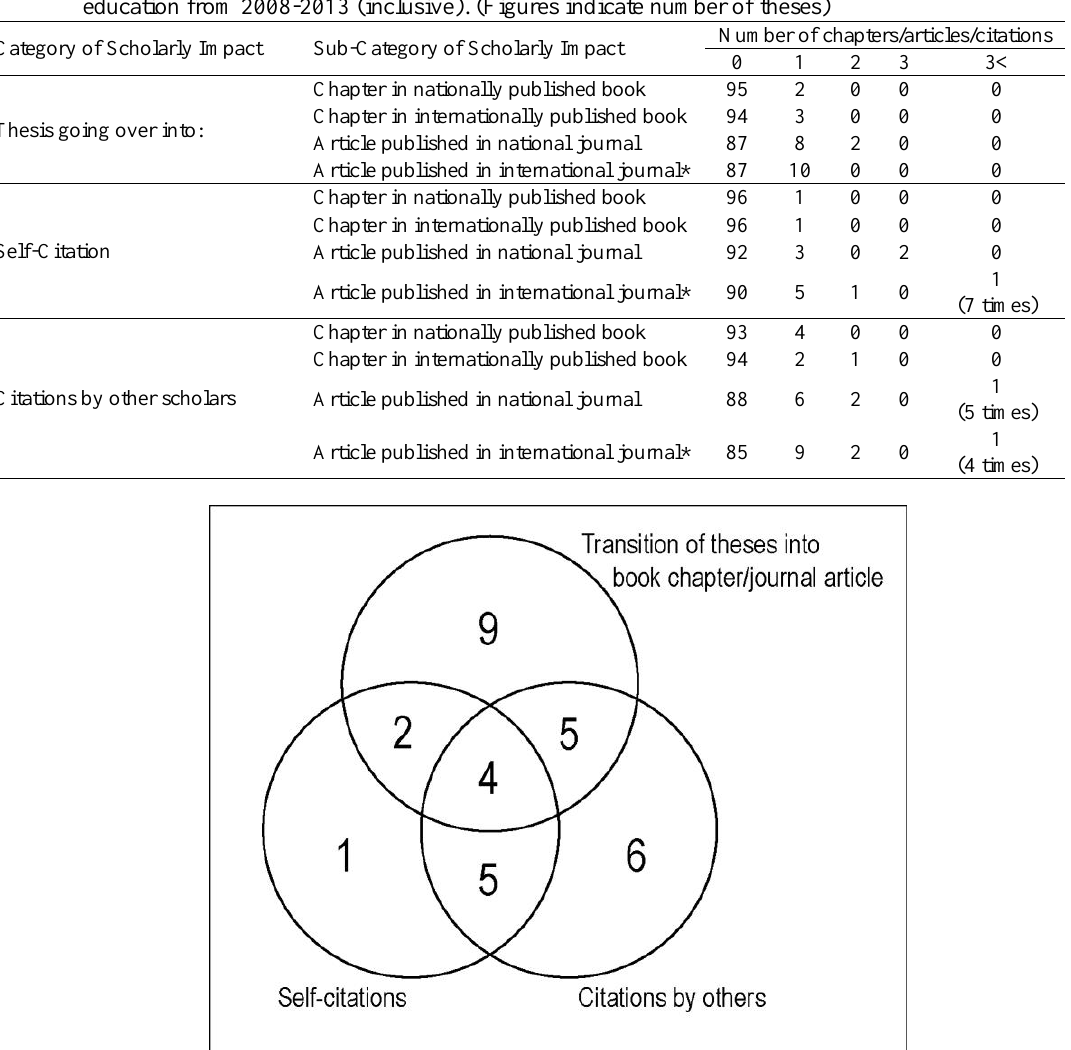
Figure 1 Scholarly Impact of Theses (Total number of theses: